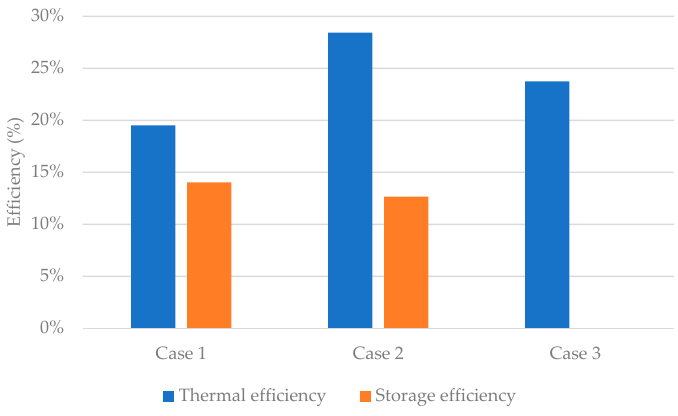
Figure 18. Estimated efficiencies of the ISD.